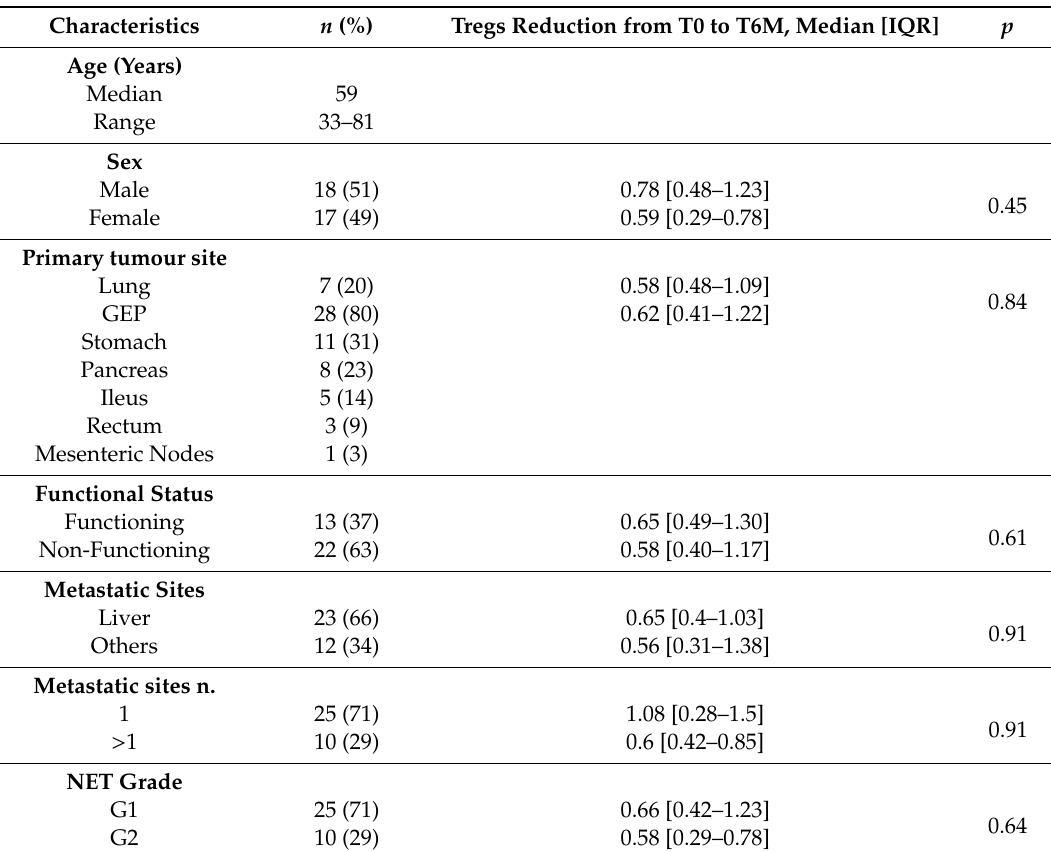
Table 1. Comparisons of patient characteristics and Tregs reduction over 6 months of somatostatin analogs (SSAs)